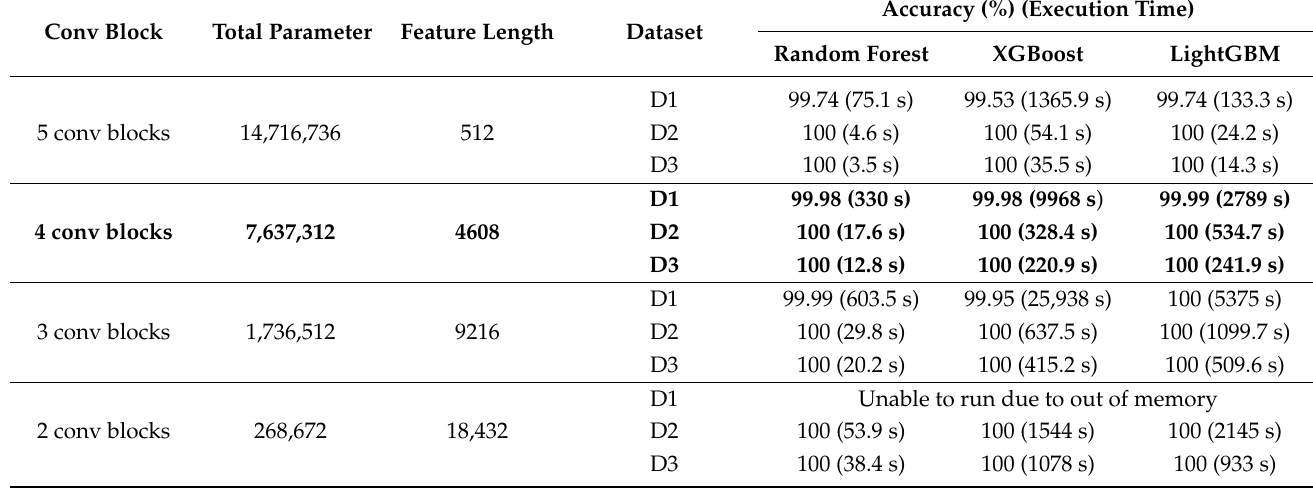
Table 4. Results of the pre-work for classifier